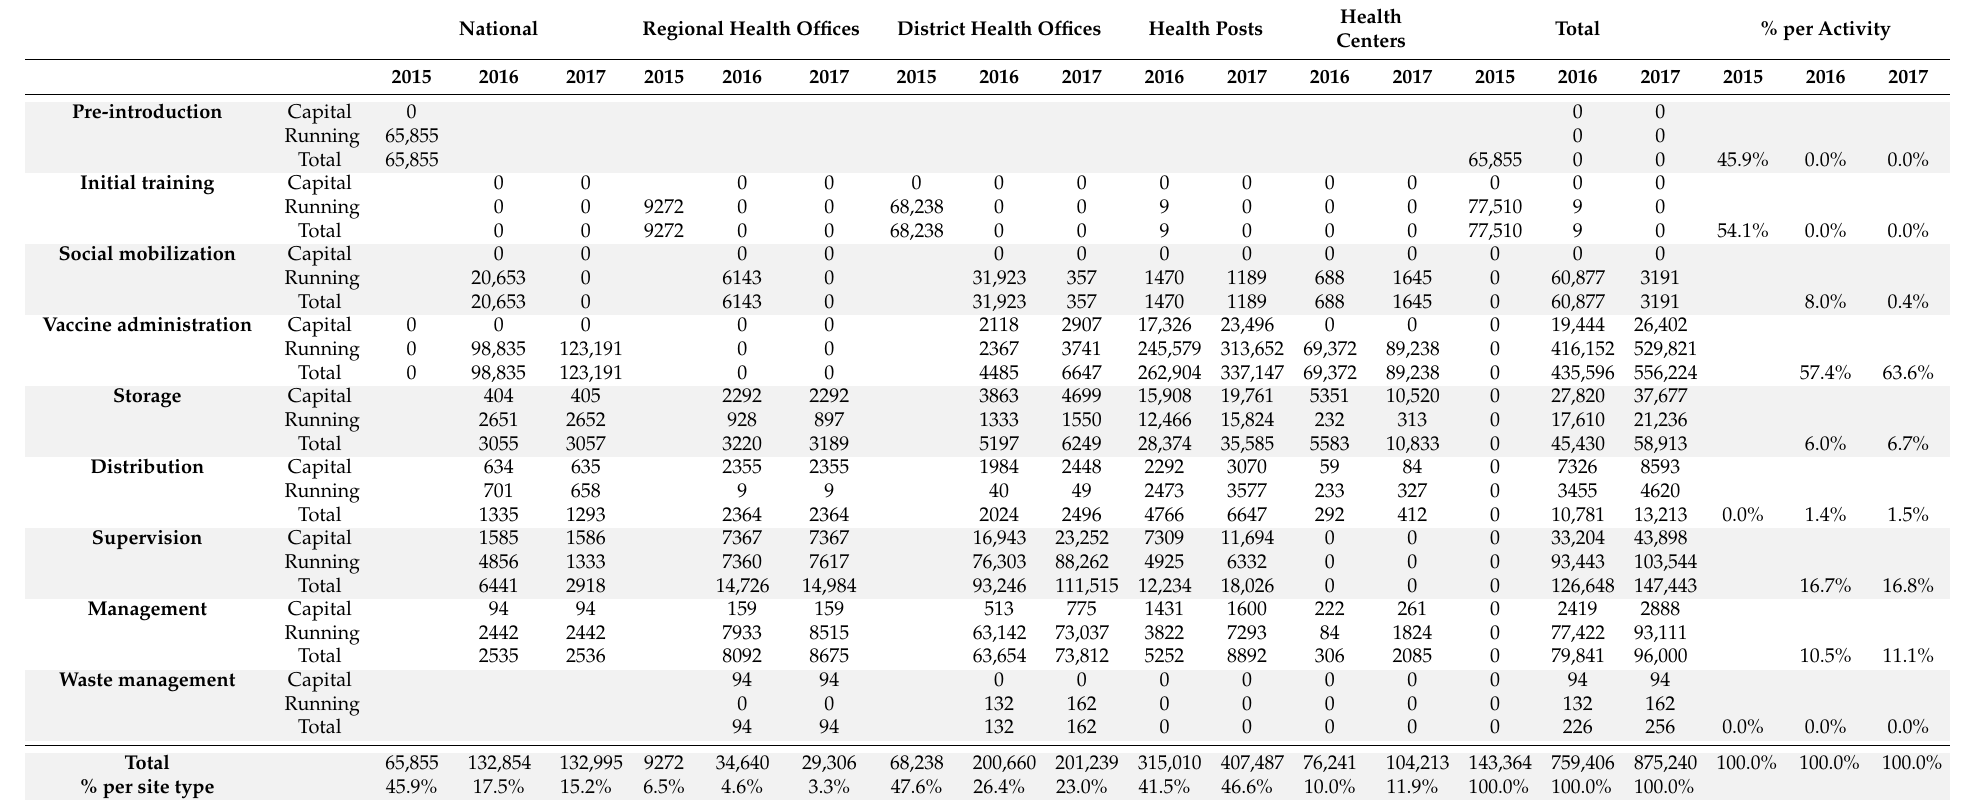
Table 3. Aggregated economic costs (in USD 2016) per activity and per study